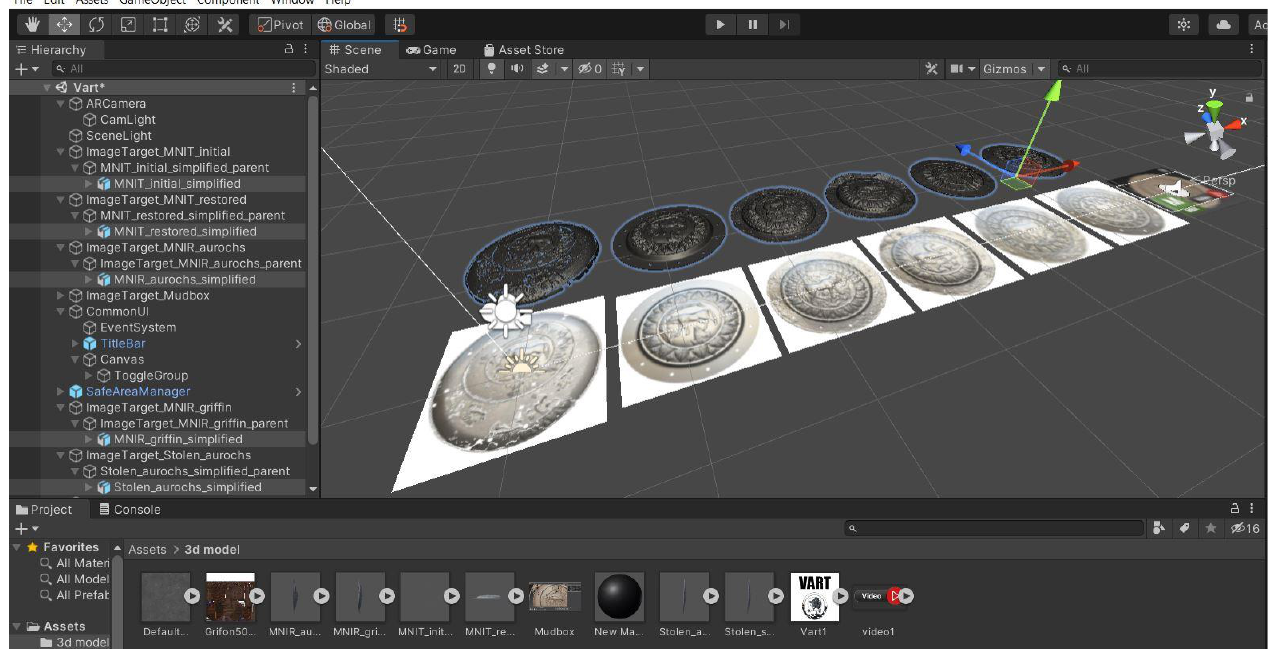
Figure 25. Grabbing, picking, and analyzing the 3D scanned and 3D reconstructed embossed disks.